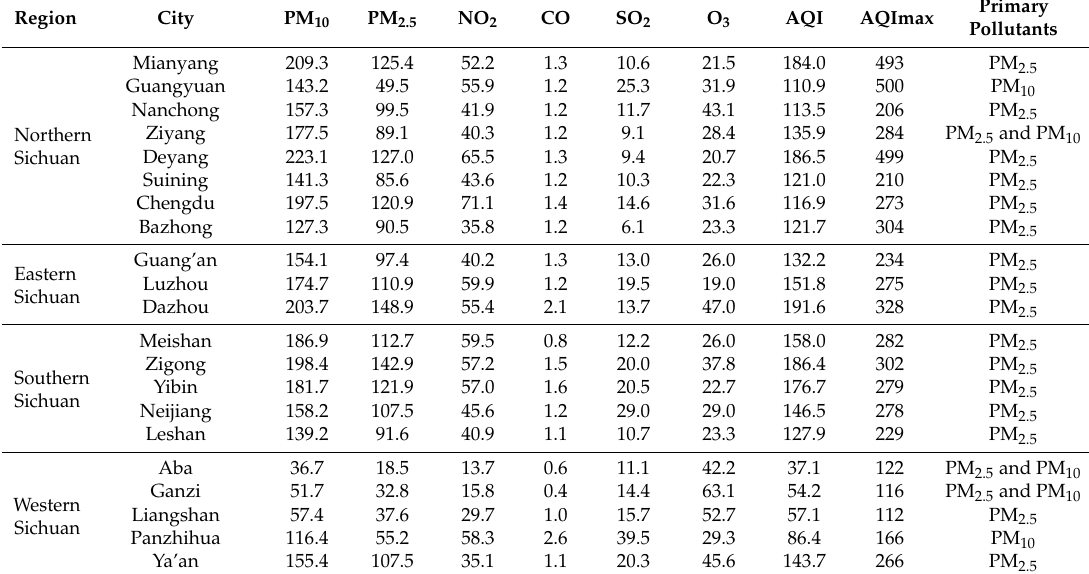
Table 2. Hourly mass concentrations for PM 10 ( µ g/m 3 ), PM 2.5 ( µ g/m 3 ), NO 2 ( µ g/m 3 ), SO 2 ( µ g/m 3 ), O 3 ( µ g/m 3 ) and the primary pollutants of each city during the process.